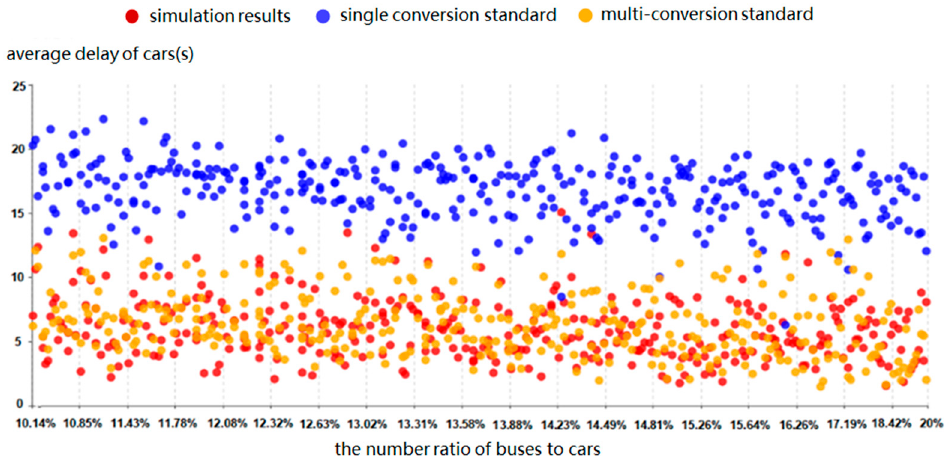
Figure 7. Average delay of